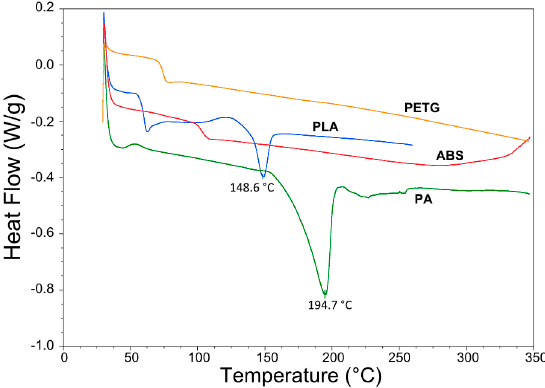
Figure 5. Digital scanning calorimetry (DSC) results of PA, PLA, PETG and ABS.